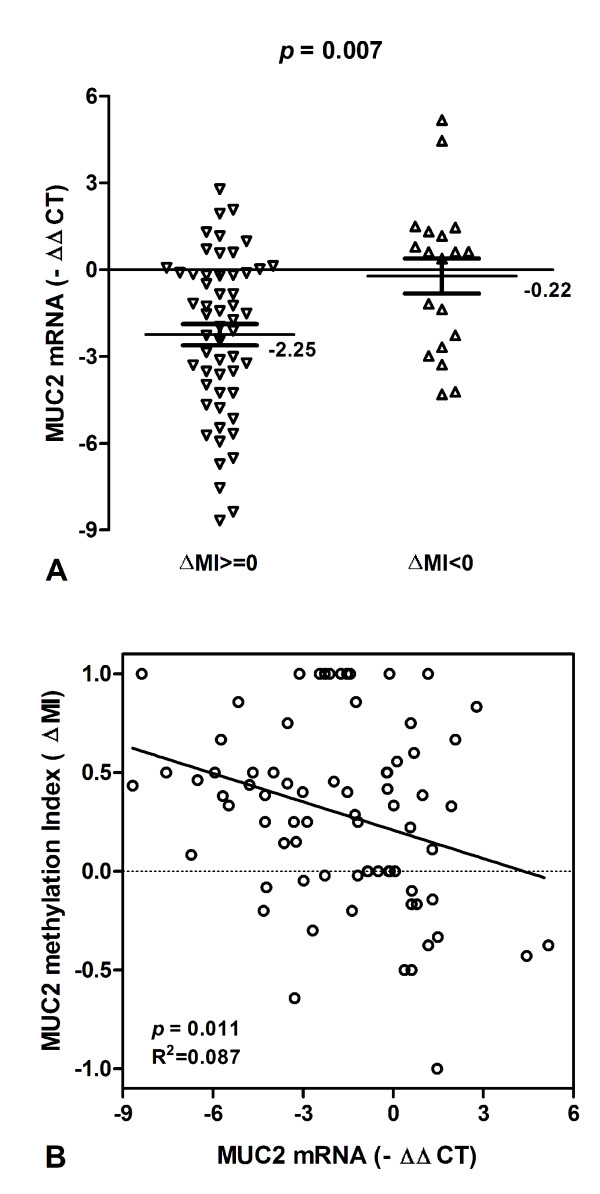
MUC2 mRNA and promoter methylation in HCC patients. (A) MUC2 mRNA expression were lower in HCC patients with ΔMI > = 0 than those with ΔMI < 0. Statistical analyses were done using the unpaired t test. (B) The scatter plots summarized relative expression levels of MUC2 mRNA (−ΔΔCT) associated with relative methylation index (ΔMI) in HCC patients. Statistical analyses were done using Pearson correlation test. -ΔΔCT, - (ΔCTHCC-ΔCTNon-HCC); ΔMI, MIHCC-MINon-HCC.